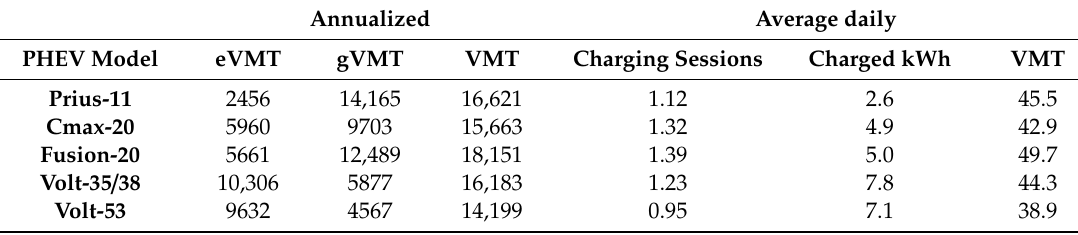
Table 2. Average annualized and daily driving and charging